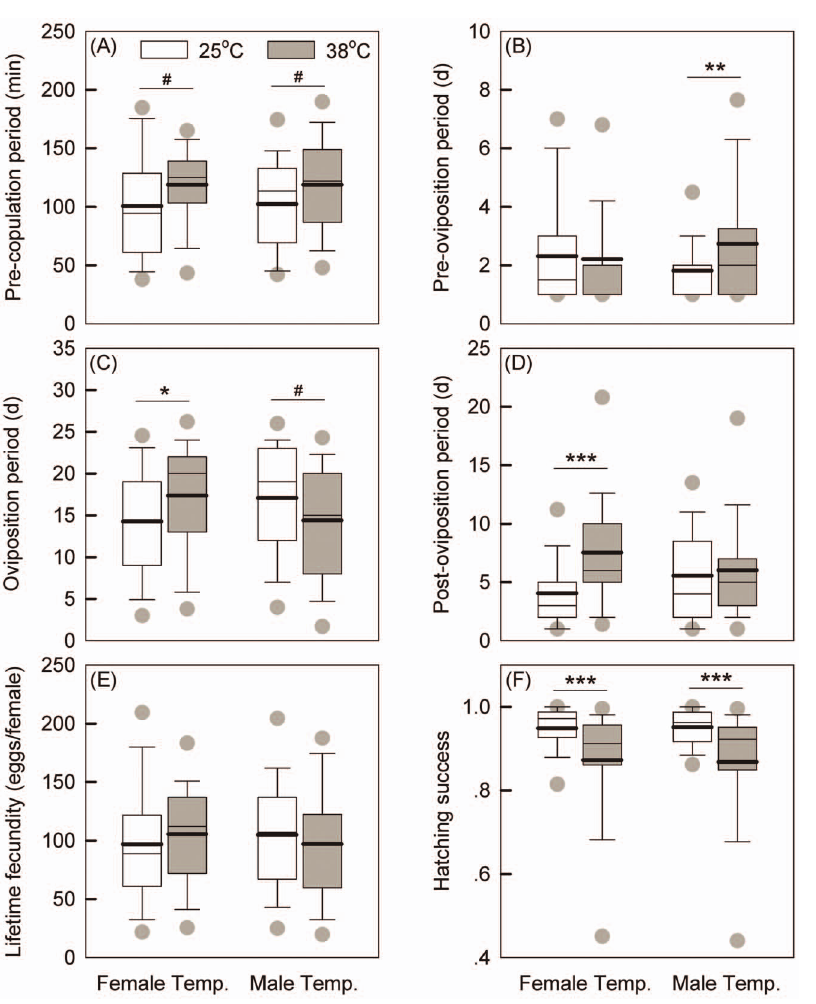
Fig. 2. Sex effects on reproduction traits after heat exposure. Treatments involved female or male treatment either at 25 ˚ C or 38 ˚ C for 4 h. The thin and thick horizontal lines within the boxes represent medians and means respectively. The asterisks (*) and octothorpes ( # ) indicate the significant differences between female or male heat treatments at different levels ( # P , 0.1; * P , 0.05; ** P , 0.01, *** P , 0.001).